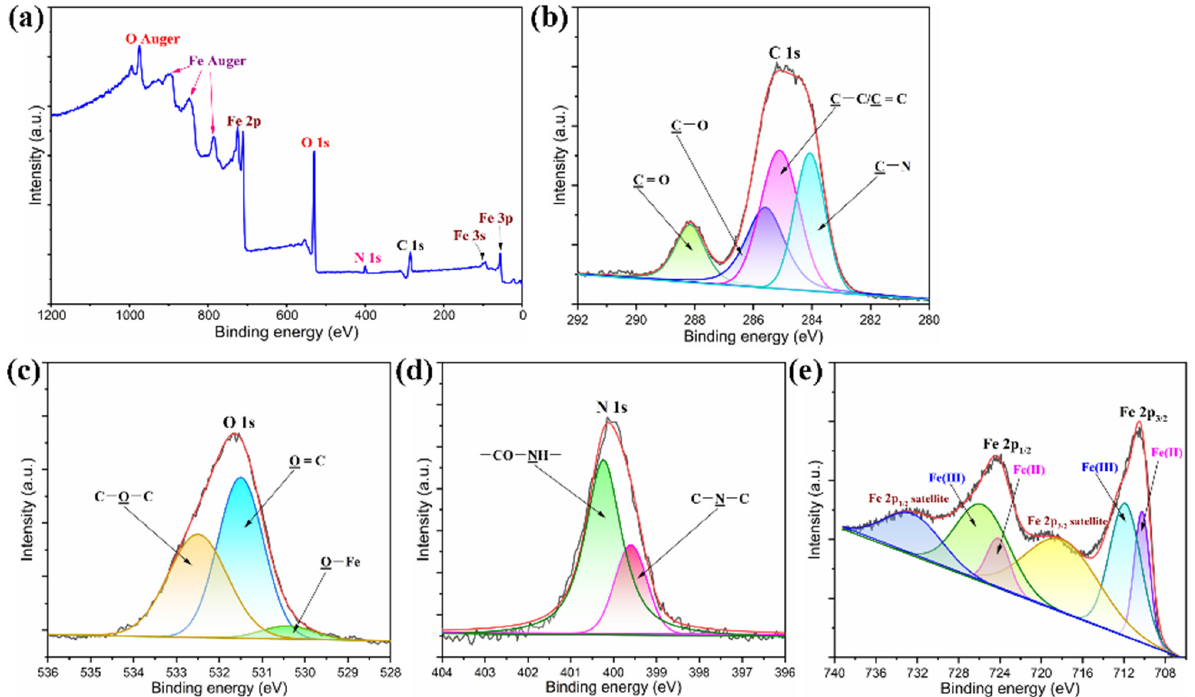
Figure 6. ( a ) XPS survey spectrum of the PI/graphene/Fe 3 O 4 hybrid aerogel film. High-resolution core-level XPS spectra and deconvoluted curves of the PI/graphene/Fe 3 O 4 hybrid aerogel film in specific binding energy of ( b ) C 1s, ( c ) O 1s, ( d ) N 1s, and ( e ) Fe 2p.